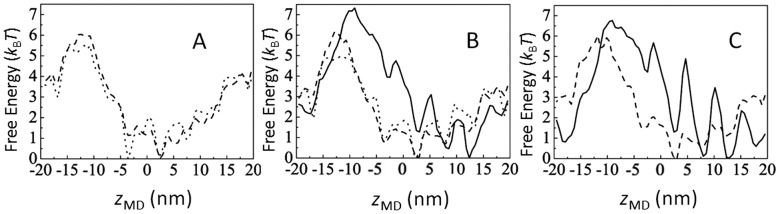
One-dimensional free-energy landscapes in different actomyosin states.Free-energy landscapes (A) in A.M.ADP.Pi with M being Mpre (dotted) and Mpost (dashed), (B) in A.M.ADP with M being Mpre (dotted), Mpost (dashed), and Mclosed (solid), and (C) in A.M with M being Mpost (dashed) and Mclosed (solid).